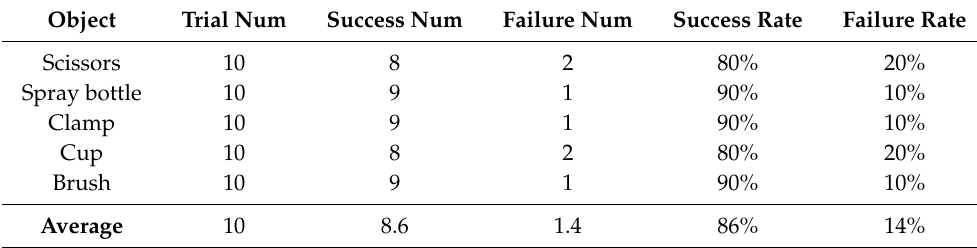
Table 2. Experiment